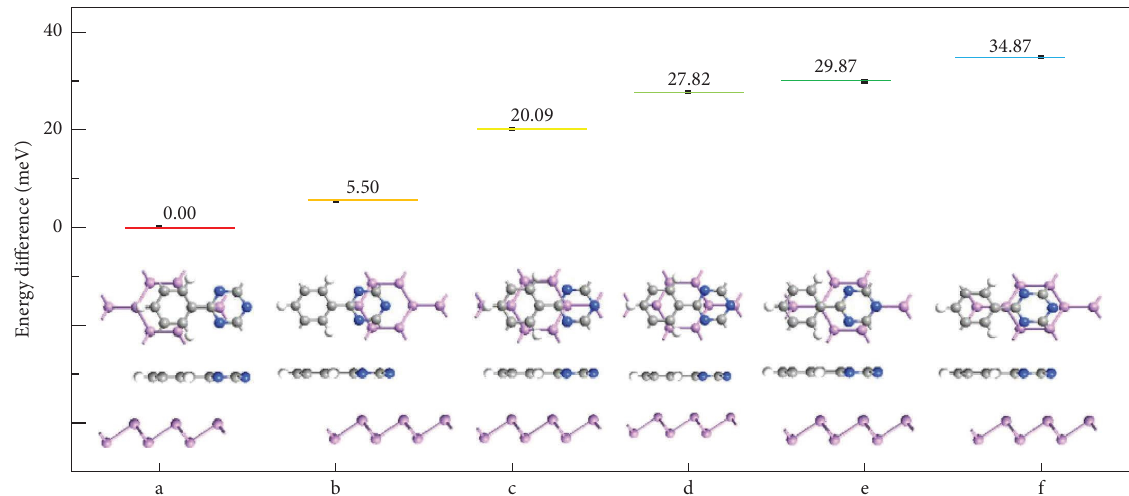
Figure 2: Total energies of CTF/As vdWhs with six diferent cases (a–f). Te insets indicate the top and side views of atomic confguration of a–f